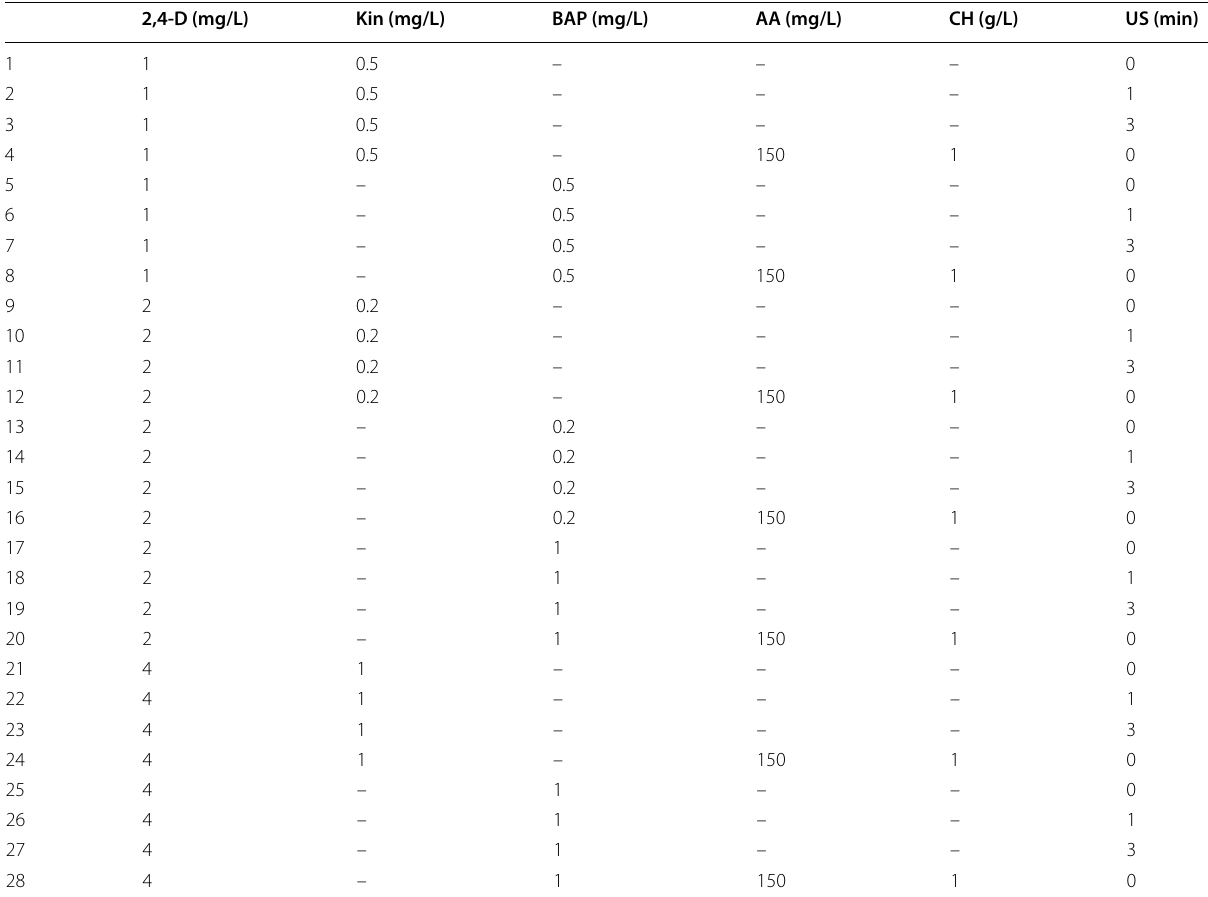
Table 1 Combination of PGRs and US exposure duration used for callus induction and growth from hazelnut on MS medium 2,4-D